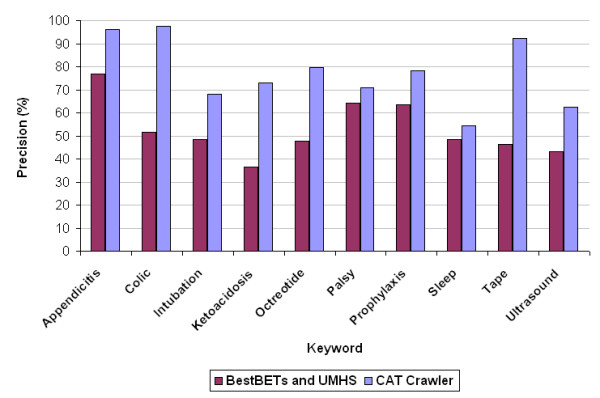
Precision plot of the CAT Crawler meta-search engine and two individual search engines